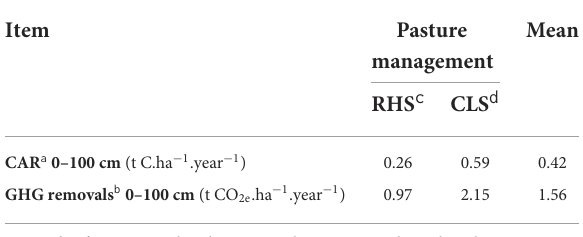
TABLE 4 Annual carbon accumulation rate in the soil and removals of greenhouse gases of two levels of intensification in grazing systems—Atlantic Forest as reference area to calculate carbon